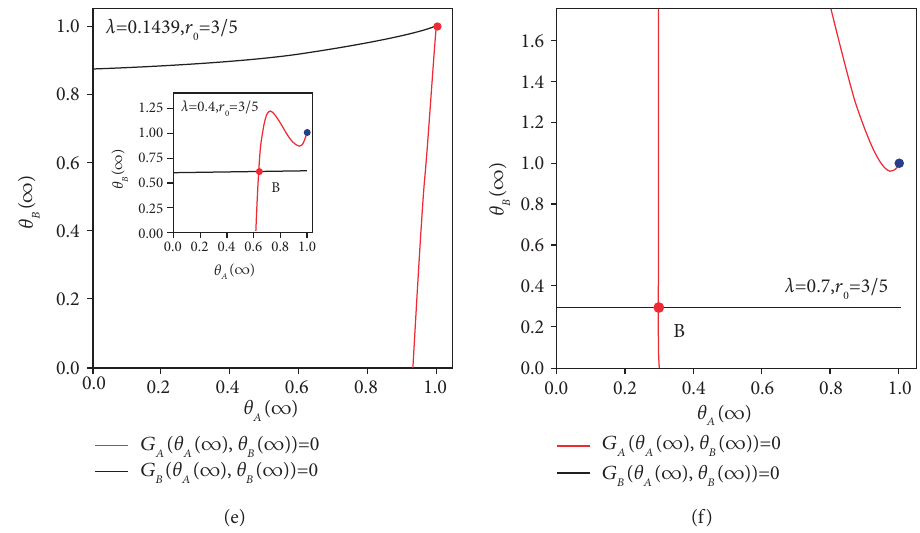
Figure 1: The change of the roots ( θ ( ∞ ) , θ ( ∞ ) ) of equation (27) at p � 0 . 9. The red and blue points are the roots of equation (27). The A B � 1/5, the change of the roots of equation (27) at red points are physically relevant roots and the blue points are other roots. In the case of r 0 (a) λ � 0.1443, and the inset of (a) λ � 0.5, (b) λ � 0.745, and the inset of (c) λ � 0.78, (d) λ � 0.8, and the inset of (d) λ � 0.82. In the case of r � 3/5, the change of the roots of equation (27) at (e) λ � 0.1439, and the inset of (e) λ � 0.4, (f) λ � 0.7. (b) It shows the change of the roots 0 of G B ( θ A ( ∞ ) , θ B ( ∞ )) at θ A ( ∞ ) � 1; the inset of (b) shows the change of the roots of G A ( θ A ( ∞ ) , θ B ( ∞ )) at θ B ( ∞ ) � 1, where the ⟶ intersections of curves and horizontal line are the roots. Other parameters: ρ B � 0 . 19, I B � T � 5, k A � k B � 10, c � 1, ε 0